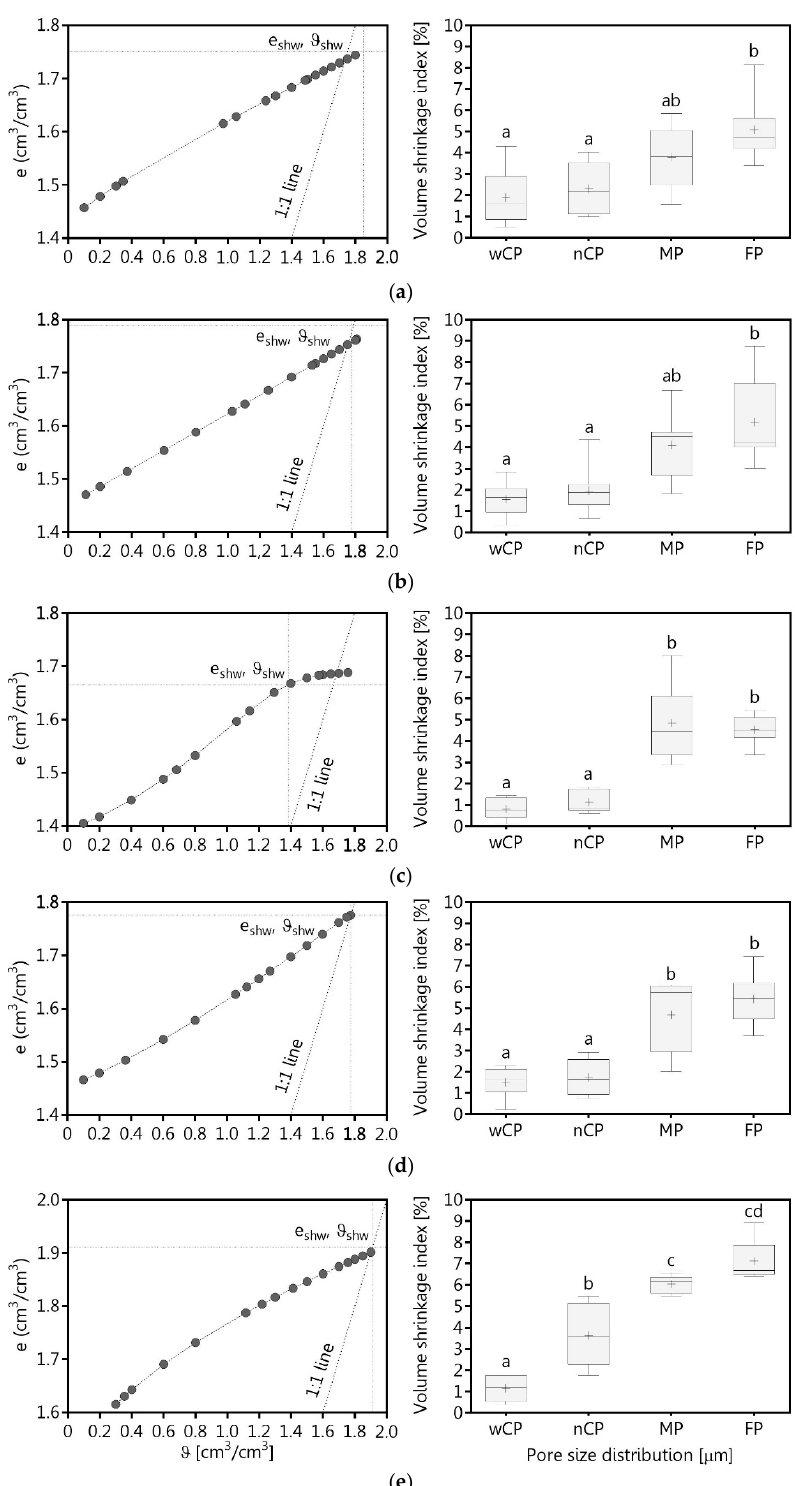
Figure 4. Shrinkage curves and volume shrinkage index of the wide coarse (wCP), narrow coarse pores (nCP), medium (MP), and fine pores (FP) of the five different Proctor stages: ( a ): mc1, ( b ): mc2, ( c ): mc3, ( d ): mc4, ( e ): mc5. Different letters indicate statistically significant differences ( p < 0.05) of the volume shrinkage index in comparison to the pore size. The transition point between the structural and the proportional shrinkage phase is marked with dashed lines (e shw and ϑ shw